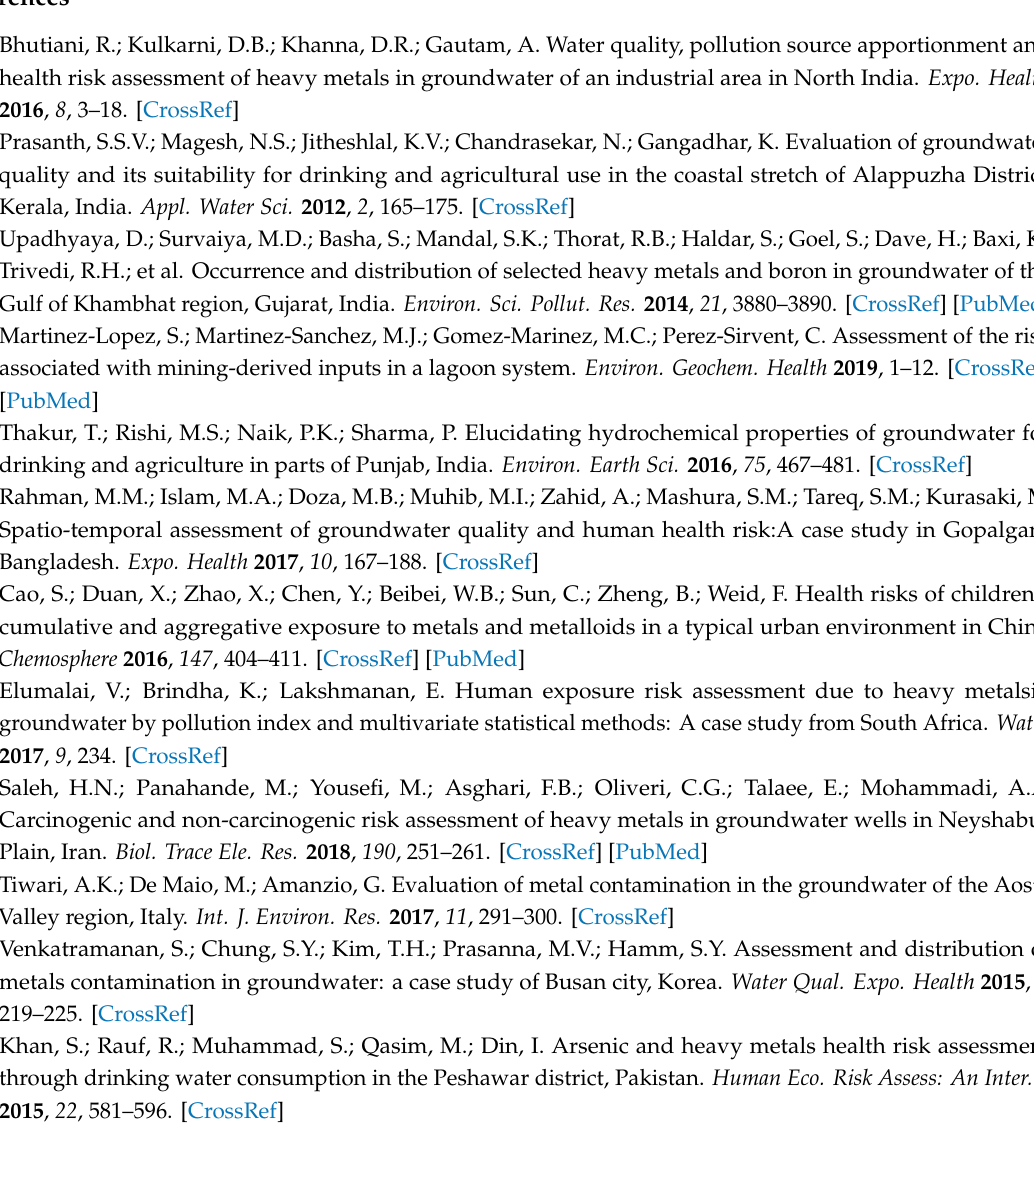
Tables S1–S5 present the supplementary data used in the analyses. Table S1: Schedule of sampling during premonsoon and post monsoon, Table S2: Description of exposure parameters for calculation of health risk assessment, Table S3: Reference dose ingestion value for heavy metals, Table S4: Reference dose dermal, skin permeability constant and cancer slope factor value for heavy metals, Table S5: Paired sample t – test for heavy metals during pre- and postmonsoon